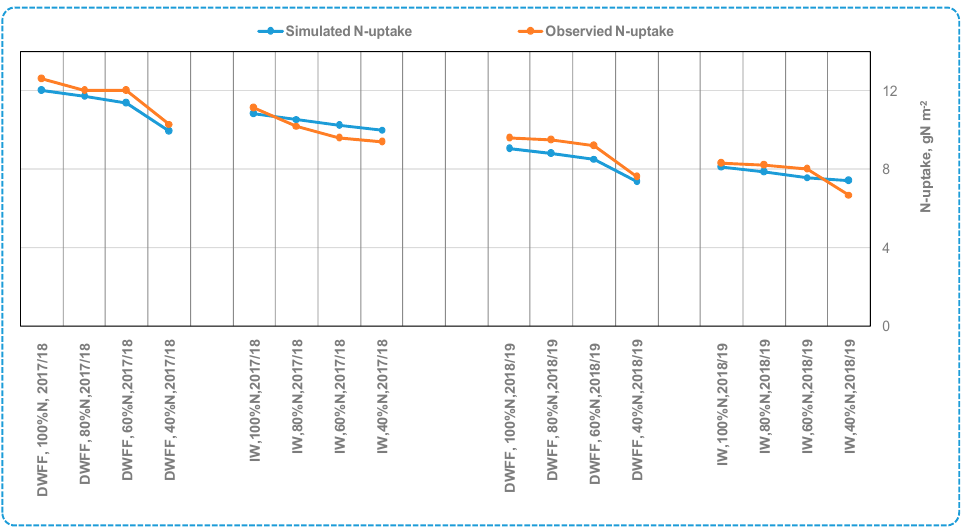
Figure 10. Observed versus simulated nitrogen concentration of the soil layer for all treatments for two seasons.